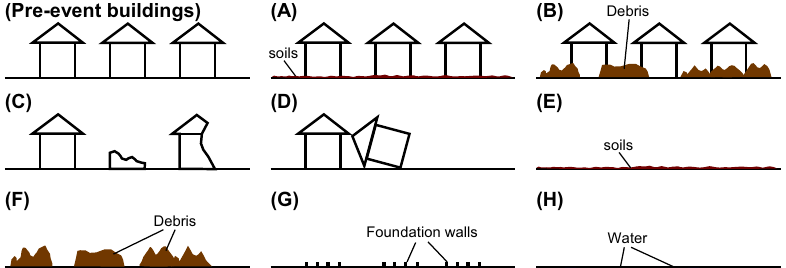
Figure 9. Example of tsunami damage patterns on buildings [46]. ( A )–( H ) are potential post-event situations. ( A ) Slightly damaged buildings caused by tsunami inundation with soil deposition, ( B ) slightly damaged buildings caused by tsunami inundation with tsunami debris, e.g., destroyed building materials, ( C ) partially destroyed buildings, ( D ) buildings displaced or overturned by tsunami inundation, ( E ) washed-away buildings with soil deposition, ( F ) washed-away buildings covered by tsunami debris, ( G ) washed-away buildings with only the foundations remained, and ( H ) washed-away buildings with remained sea